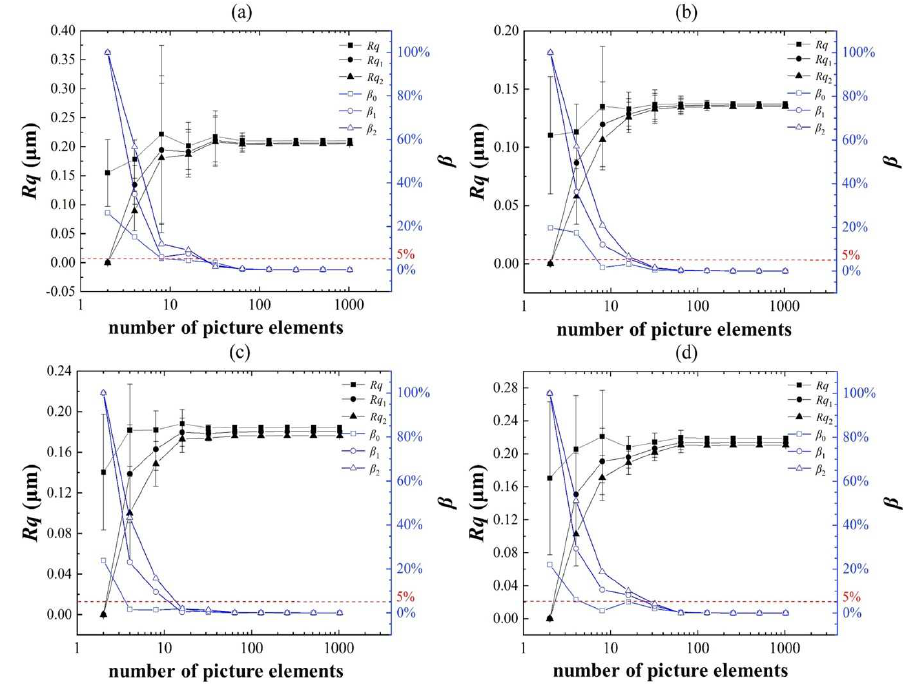
Figure 8. Rq values obtained by using different number of picture elements and flatten orders for the surfaces of a milled workpiece. The subfigures ( a – d ) represented four different positions randomly selected on the surface,